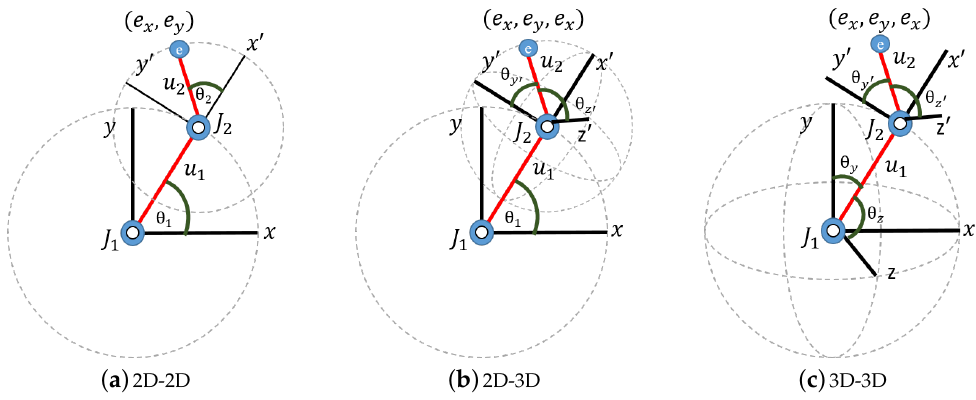
Figure 4. ( a ) shows the 2D-2D version of the double pendulum where both limbs are rotating in a two-dimensional plane. x and y are the local coordinate axes of limb u 1 . x (cid:48) and y (cid:48) are the local axes of limb u 2 . ( e x , e y ) are the end-effector coordinates. ( b ) shows the 2D-3D version of the double pendulum where limb u 1 is in a two-dimensional plane and limb u 2 is rotating on a sphere in three-dimensional space. x and y are the local coordinate axes of limb u 1 . x (cid:48) , y (cid:48) and z (cid:48) are the local coordinate axes of limb u 2 , and ( e x , e y , e z ) are the end-effector coordinates. ( c ) shows the 3D-3D version of the double pendulum where both limbs are rotating on spheres in three-dimensional space. x , y and z are the local axes of limb u 1 . x (cid:48) , y (cid:48) and z (cid:48) are the local axes of limb u 2 , and ( e x , e y , e z ) are the end-effector